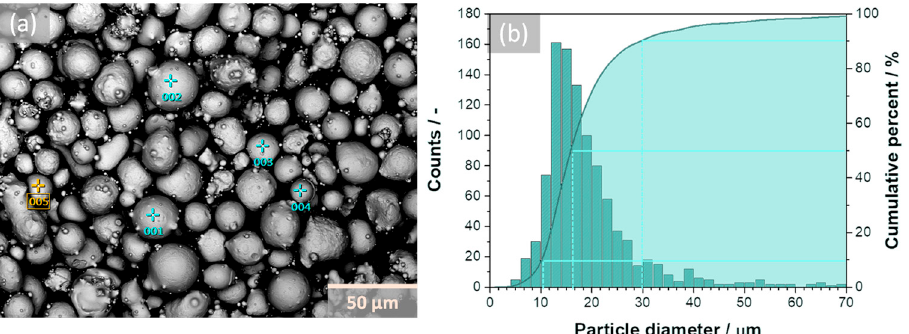
Figure 2. Characterization of the Cu ‐ Al ‐ Ni ‐ Fe feed powder: ( a ) Morphology as seen in FE ‐ SEM and ( b ) particle size distribution. ( b ) particle size